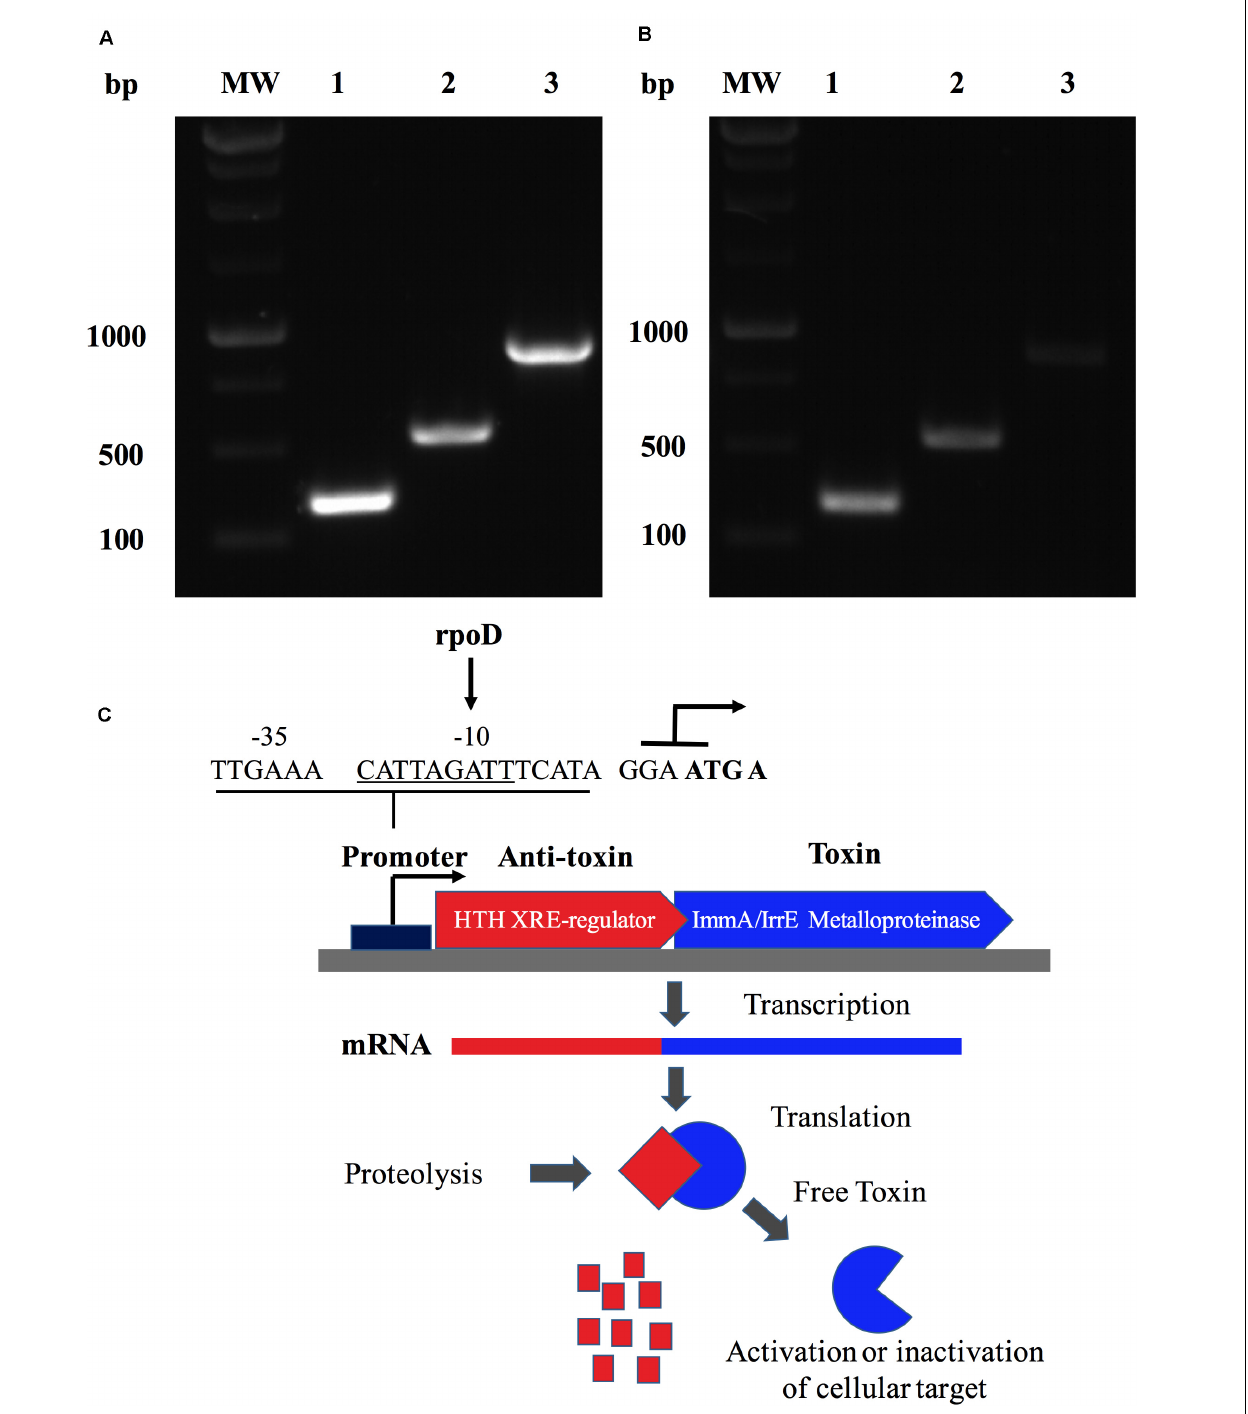
FIGURE 2 | A Zinc-dependent metalloproteinase of B. abortus is an operon that forms a putative type II toxin-antitoxin. Identification of the transcriptional unit (operon) constituted by ORF BAB1_0270 and a transcriptional regulator in B. abortus 2308 expressed in (A) the genomic DNA and (B) the cDNA from total RNA. MW: Molecular weight; lane 1: Transcriptional regulator (357 bp); lane 2: BAB1_0270 (549 bp); and lane 3: operon constituted by ORF BAB1_0270-transcriptional regulator (906 bp). (C) Hypothetical Type II toxin-antitoxin (TA) model for operon constitute by ZnMP and transcriptional regulator. Toxin (ZnMP) and anti-toxin (transcriptional regulator) are transcribed to mRNA together. Proteases are activated under stress conditions, cleaving the anti-toxin, which increases the levels of toxin-free, inducing various biological functions in bacteria. Predicted promoter at site -35 and -10 binding by RNA polymerase sigma factor rpoD. ATG A: nucleotides shared between final part of transcriptional factor and metalloproteinase codified for ORF BAB1_0270.